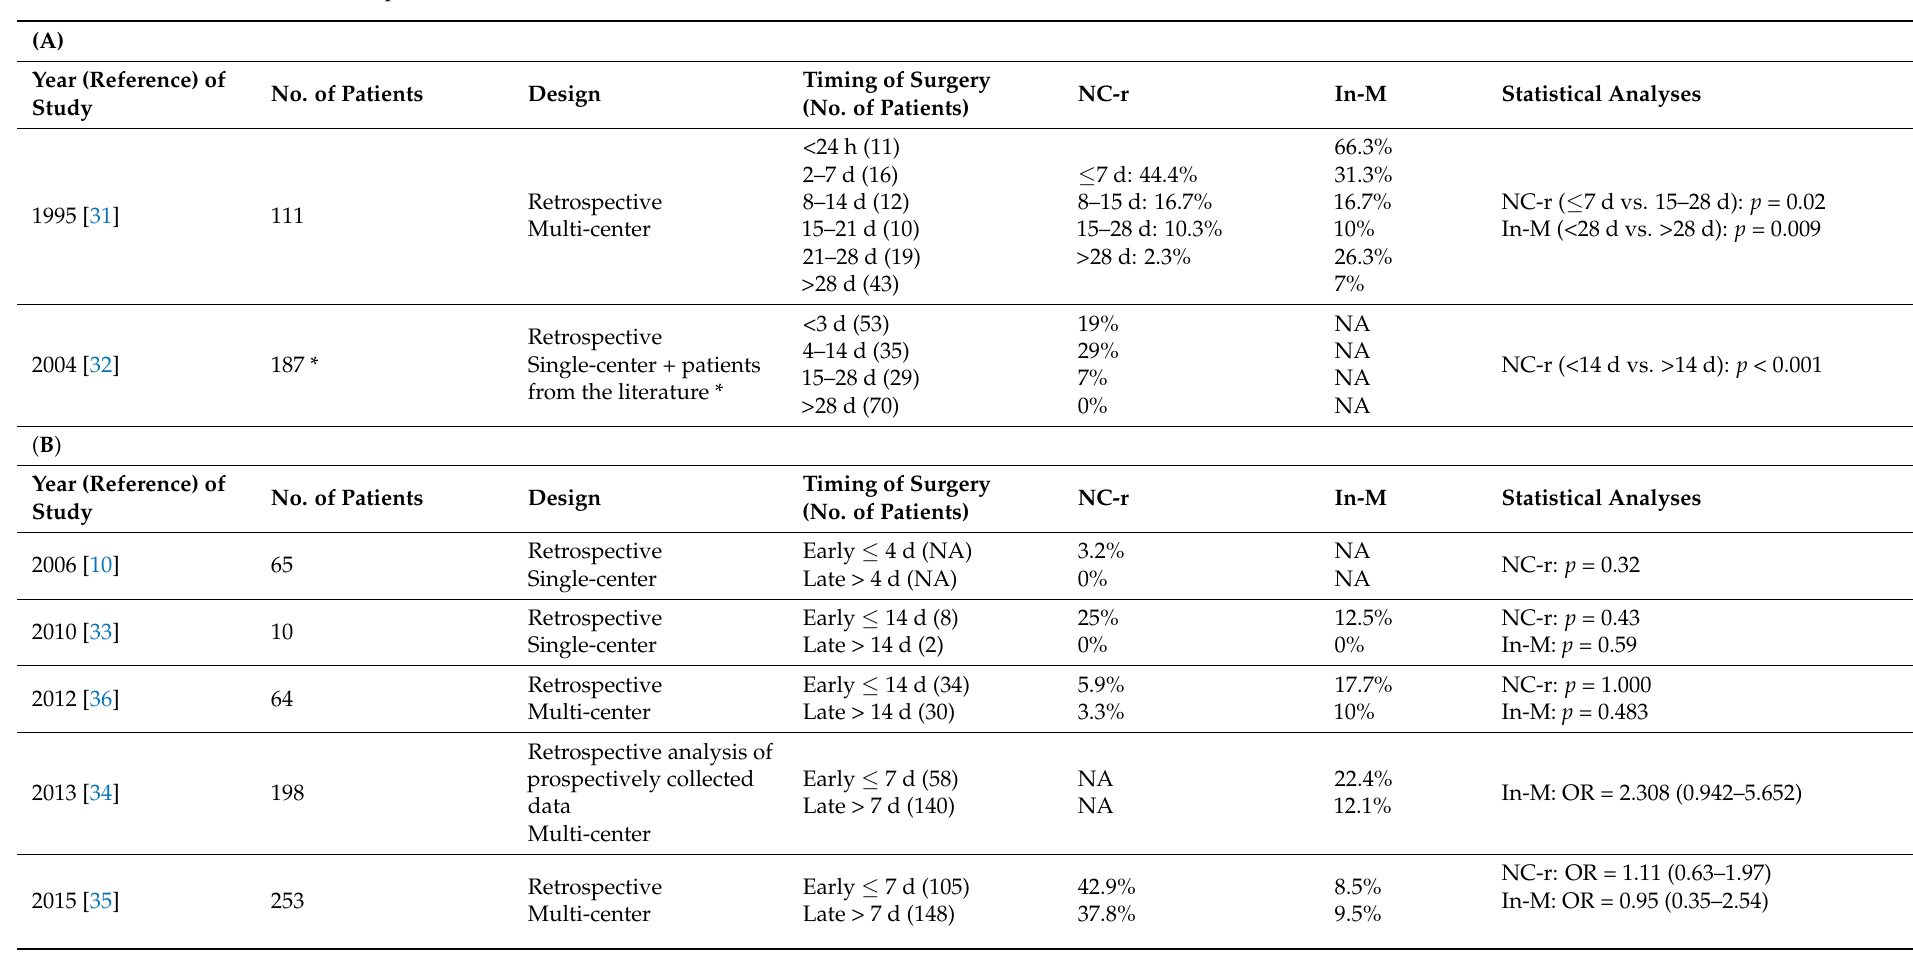
Table 1. Results from different studies favoring late (part A) vs. early (part B) cardiac surgery in patients with infective endocarditis and ischemic neurological